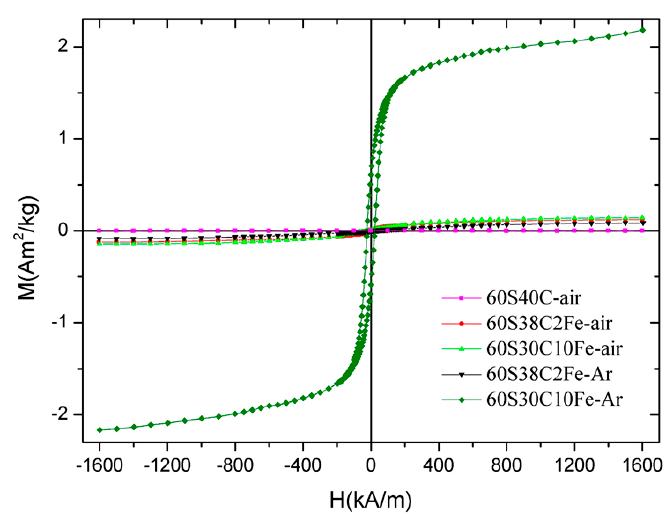
Figure 8. Magnetization curves (hysteresis cycles) of the calcined materials up to 1600 kA/m. Table 5. Magnetic parameters evaluated from hysteresis cycles of the calcined materials.